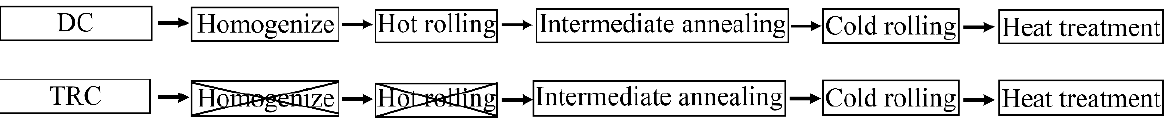
Figure 1. Schematic diagram of DC and TRC process of Al-Mg-Si alloy sheet.